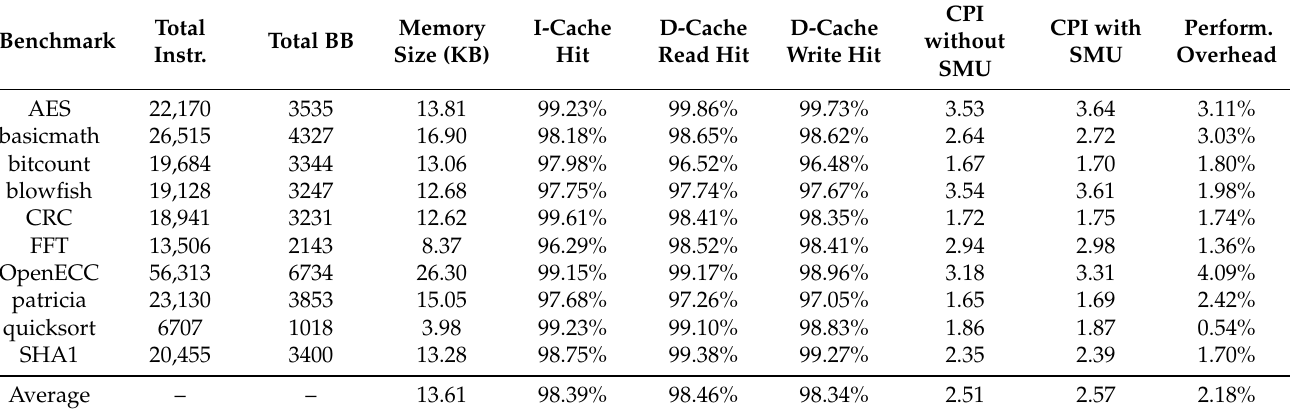
Table 1. Performance overhead of SoC configured with SMU (8 KB I-Cache and 8 KB D-Cache).